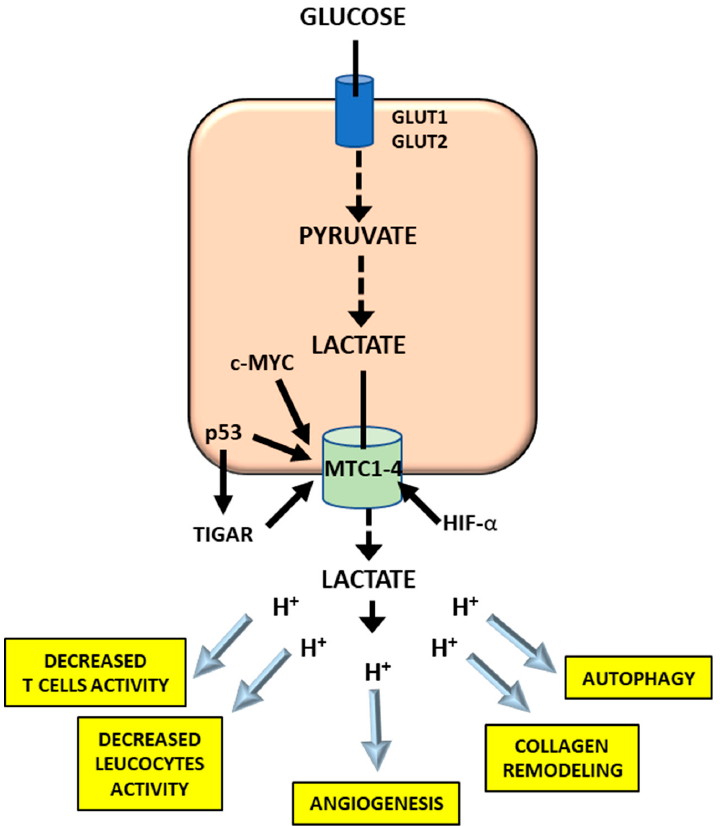
Figure 4. Effects of the lactic acid export of cells outside. Explanations in the text. Figure 4. E ff ects of the lactic acid export of cells outside. Explanations in the